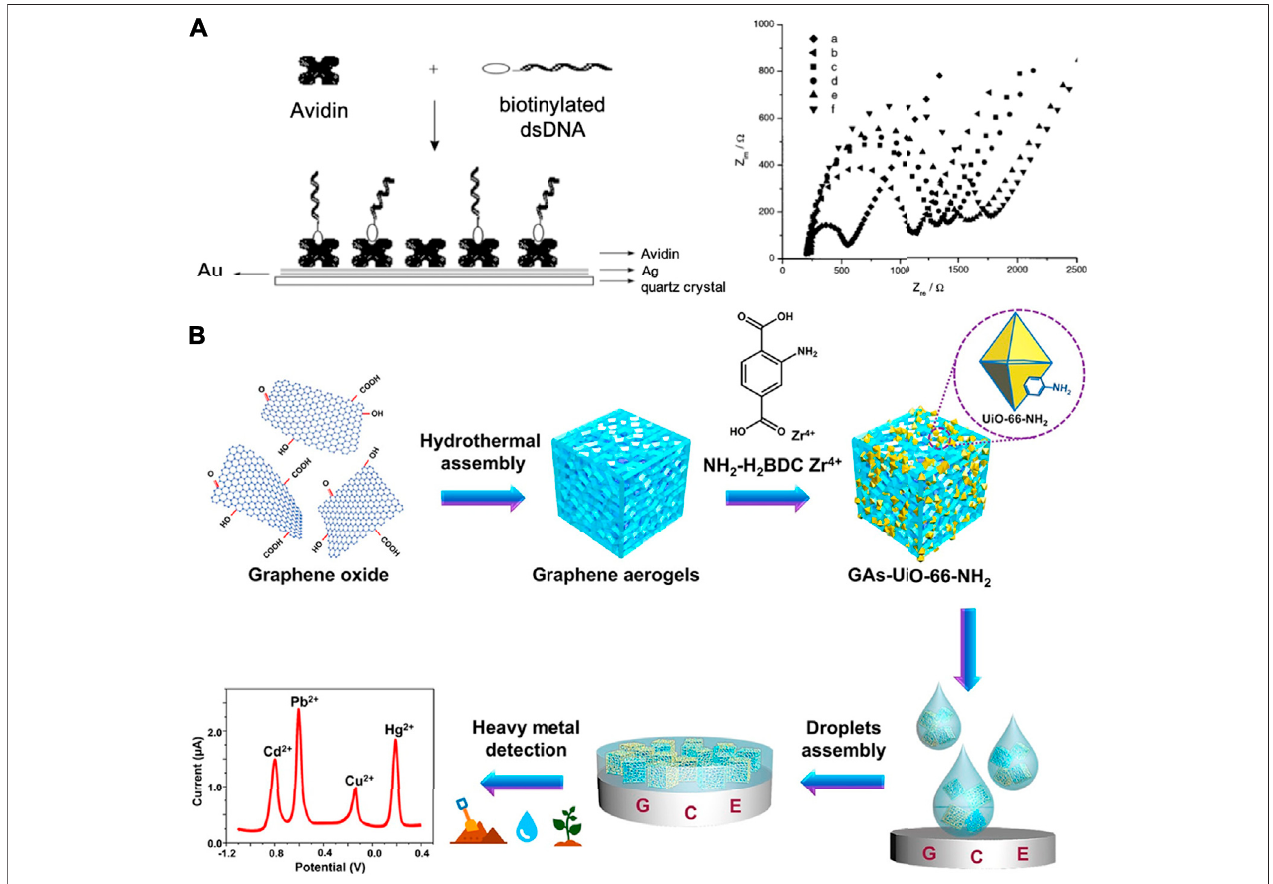
FIGURE 6 | Examples of supramolecular biosensors with electrical readouts. (A) Sensor interface immobilized with double-stranded DNA onto electrodeposited avidin monolayer (left) and impedance measurements in the presence of Fe(CN 6 ) 3-/4- using Au-based electrode with different surface modi fi cation (right) . (B) Electrochemical sensor based on a composite of graphene aerogel and metal-organic framework for simultaneous detection of multiple heavy-metal ions in aqueous solutions. Adapted from (Yan and Sadik, 2001; Lu et al., 2019). Copyright 2001, 2019 American Chemical Society.